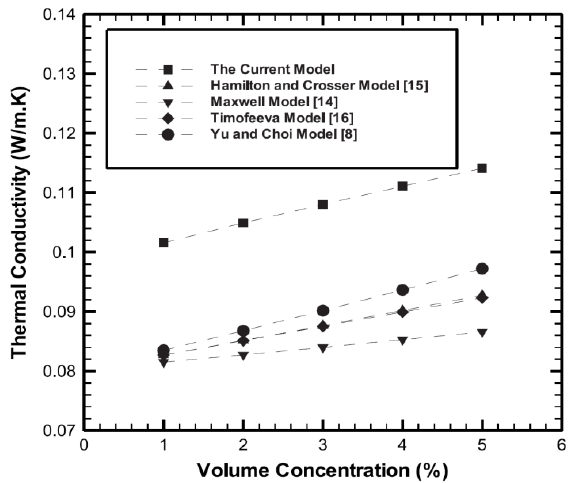
Figure 1. Variation in thermal conductivity of CuO/R134a as a function of particle volume fraction (at 300 K) [20].